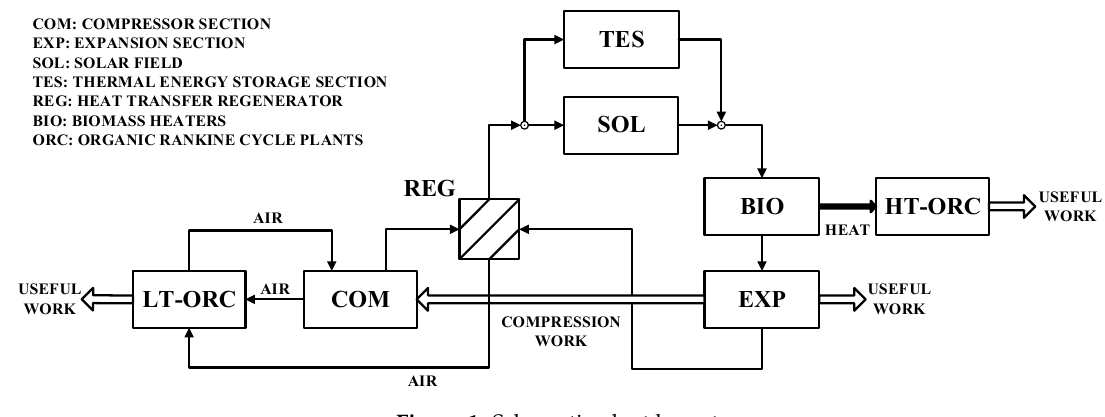
Figure 1. Schematic plant layout.